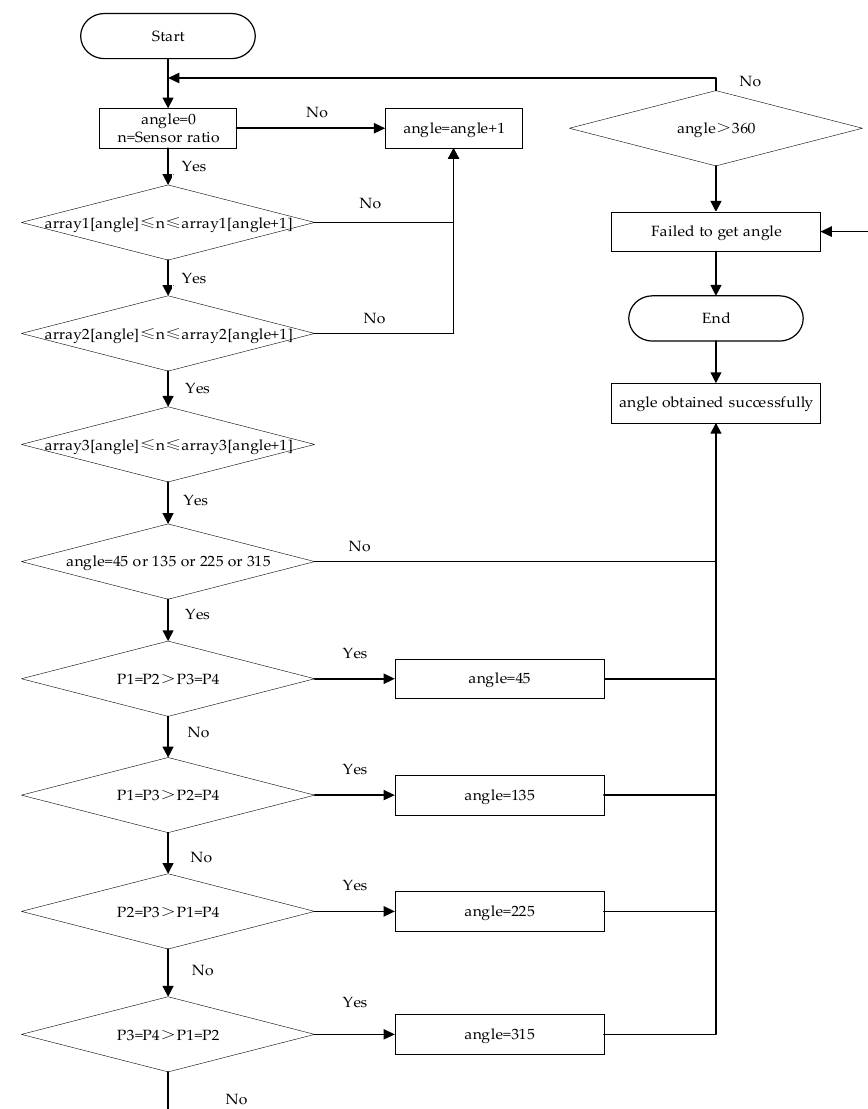
Figure 3. Flow chart of table lookup method.